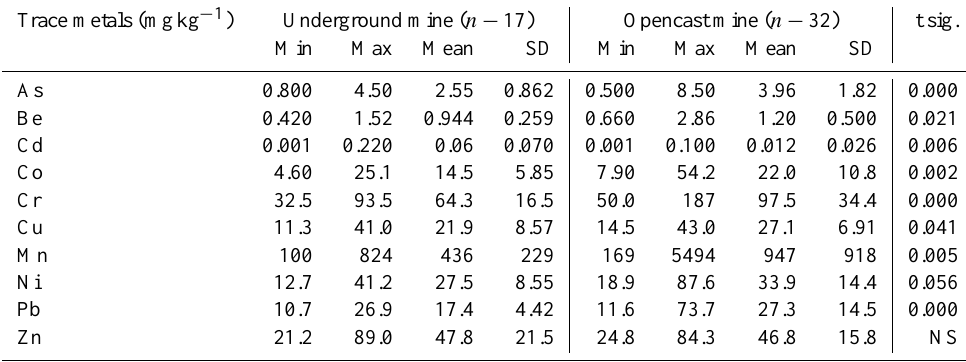
Table 2. Soil trace metal contents in the opencast and underground mining site. Trace metals (mgkg − 1 ) Underground mine ( n −